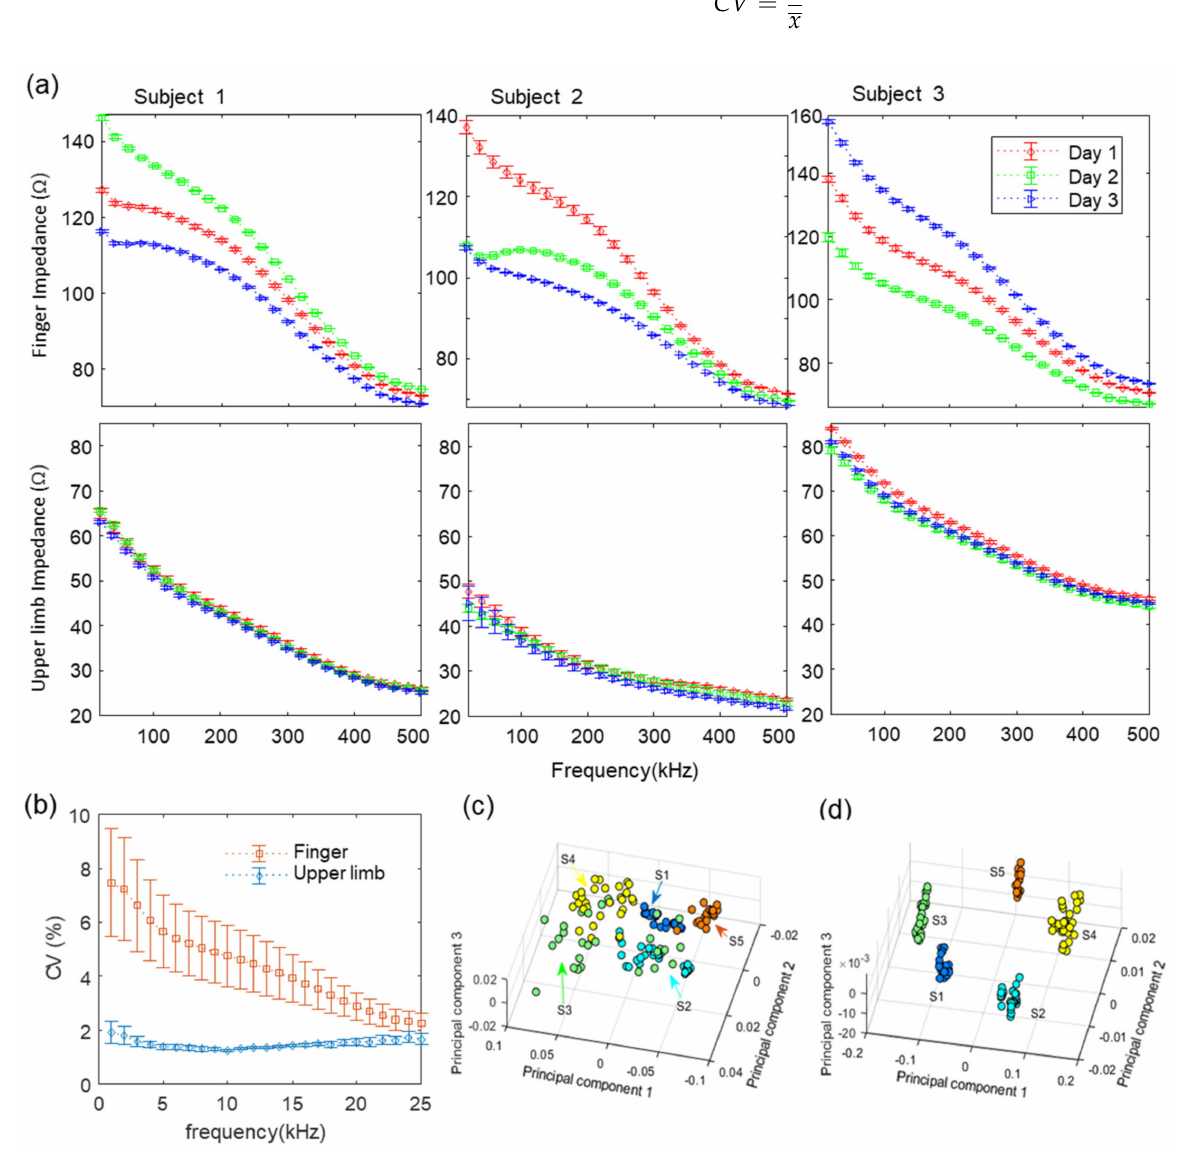
Figure 4. Comparison of temporal variation in finger and upper limb impedance features. The impedance of fingers and upper limbs were obtained over three independent days. ( a ) Finger (above) and upper limb (below) impedances of three representative subjects measured over three independent days for assessing temporal variation. The error bars in the figure indicate the relative standard deviation ( n = 10). ( b ) Coefficients of variation of finger impedance and upper limb impedance. ( c ) Scatter plot of the first three principal components of the finger impedance from principal component analysis. ( d ) Scatter plot of the first three principal components of the upper limb impedance from principal component